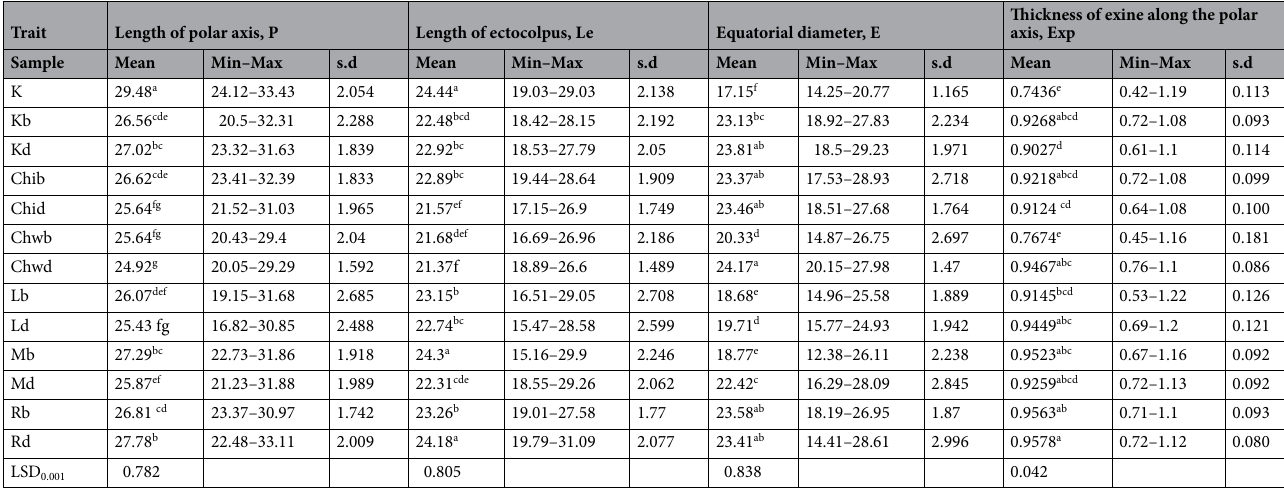
Table 2. Mean values and standard deviations for length of polar axis (P), length of ectocolpus (Le), equatorial diameter (E) and thickness of exine along the polar axis (Exp). Samples: K – trees without any treatment, Kd – trees with drilling, Kb – trees with bark incision as well as five different herbicides: Chi – Chikara, Chw – Chwastox, L – Logo, M – Mustang, R – Roundup and two methods of their application: d – drilling or b – incision. a–f In columns, means followed by the same letters are not significantly